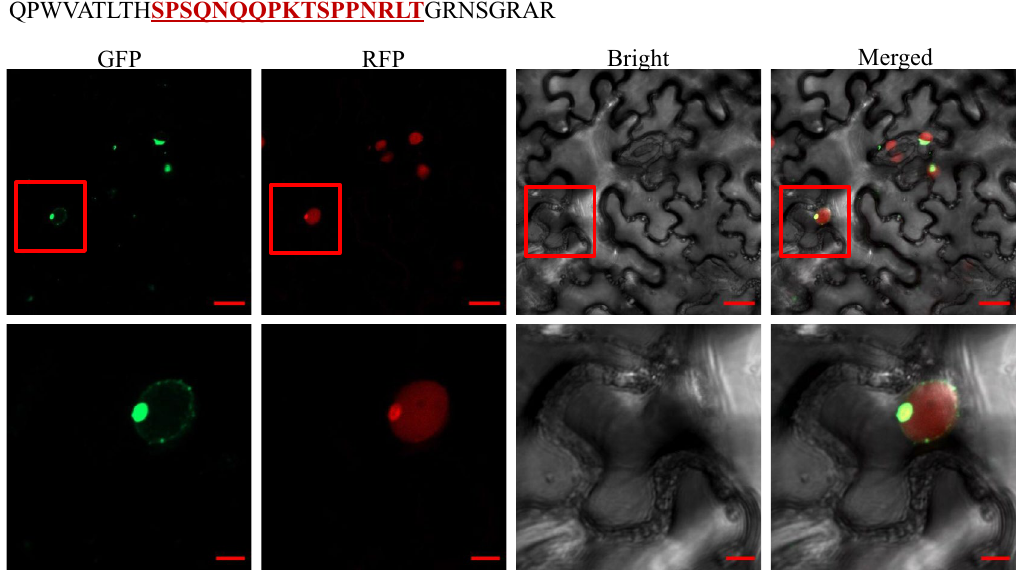
Figure 2. Subcellular localization of 17K in N. benthamiana epidermal cells. ( A ) Online analysis of the 17K nuclear localization signal using PortII (https:// psort. hgc. jp/ form2. html) and seqNLS (http:// mleg. cse. sc. edu/ seqNLS). The predicted nuclear localization signal sequence is colored in red and underlined. ( B ) Localization of 17K in N. benthamiana epidermal cells. GFP-tagged 17K (17K-GFP) was expressed in planta . Confocal images were taken at 2 dpi. Bars represent 20 μm and 5 μm, respectively.